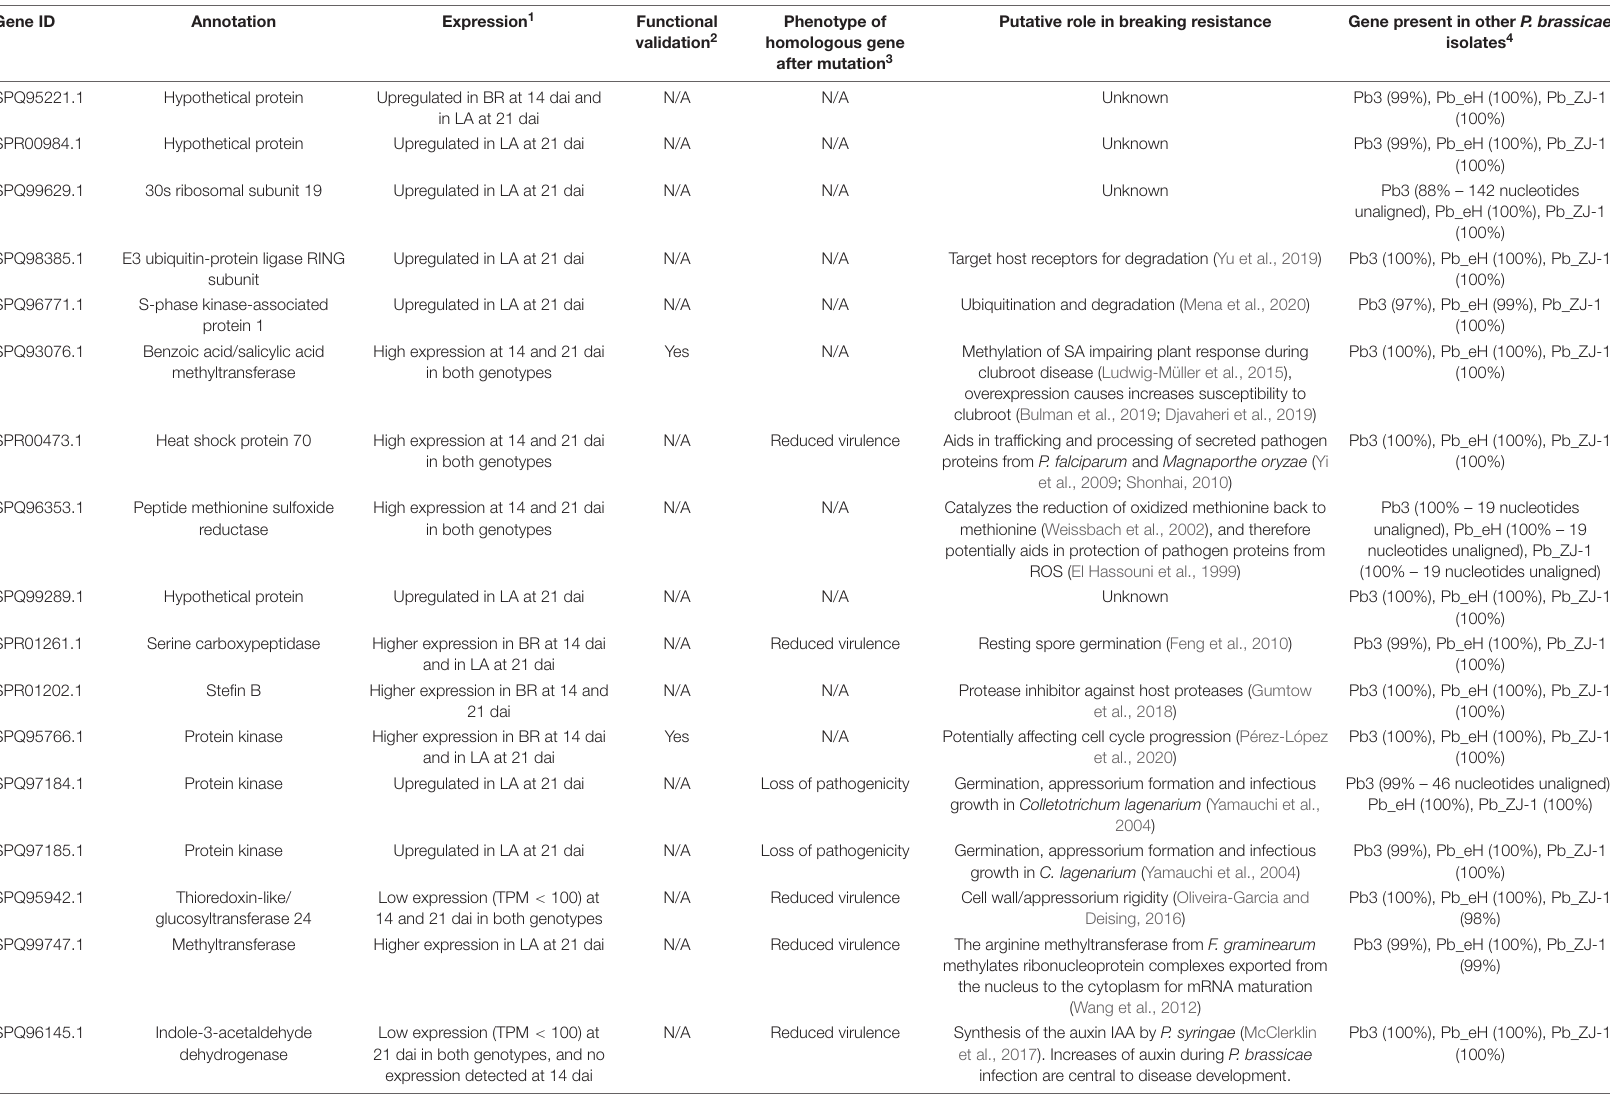
TABLE 3 | Summary of most relevant P. brassicae effector